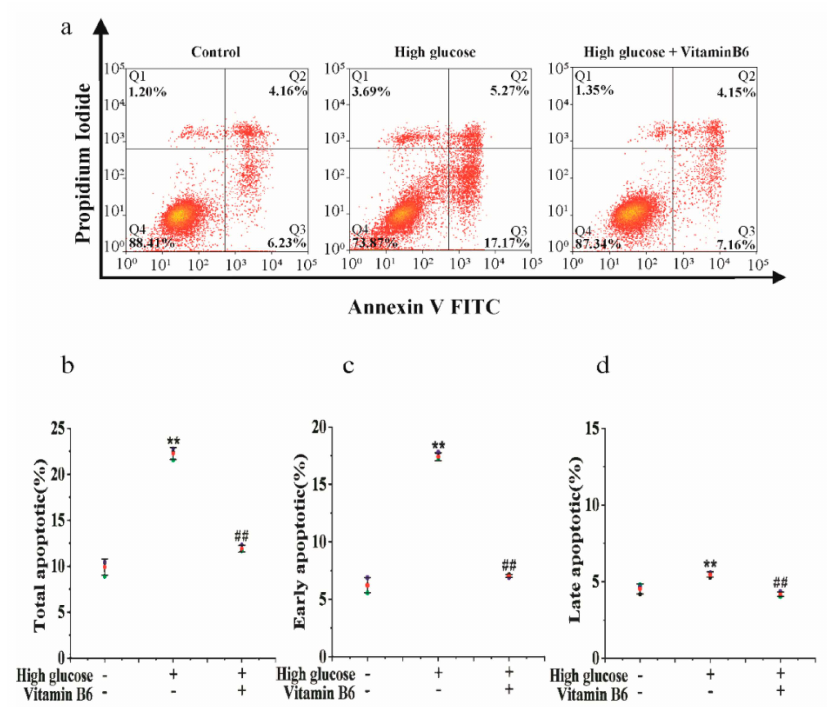
Figure 1. Vitamin B6 protected cells from apoptosis induced by high glucose. ( a ) Apoptosis rates of RIN-m5F cells cultured with or without 20 µ M glucose or with 20 µ M vitamin B6 plus 20 µ M glucose for 36 h were measured by flow cytometry. ( b – d ) Cells were treated as described in ( a ), and total apoptosis, late apoptosis, and early apoptosis were analyzed. The experiment was repeated at least three times (Error bars, s.d ** p < 0.01 indicates significant differences compared with the control group by one-way ANOVA. ## p < 0.01 indicates significant differences compared to the high glucose-treated group by one-way